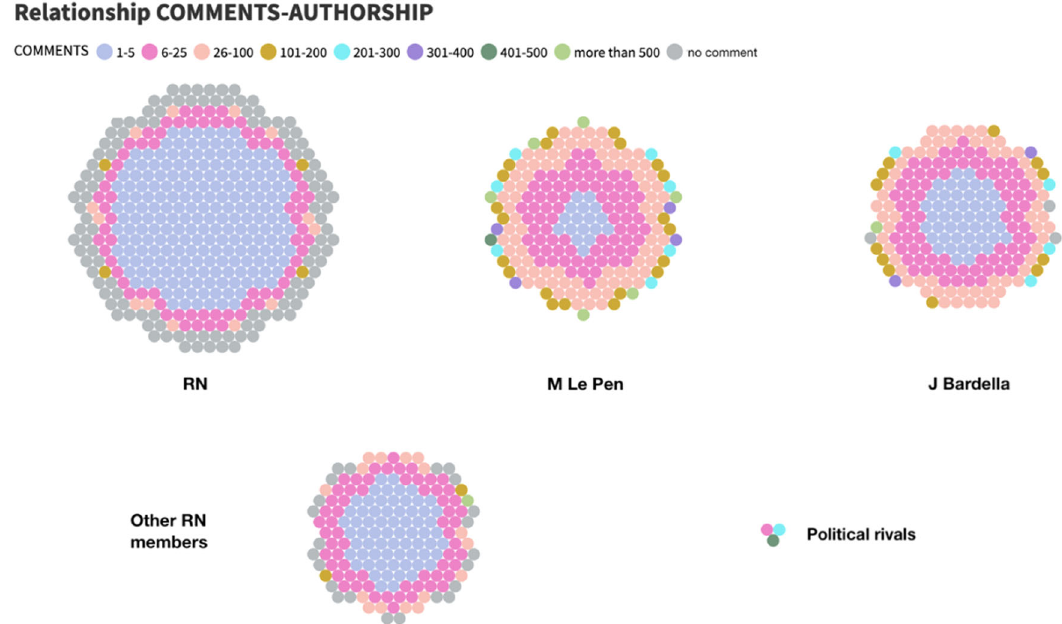
Fig. 5 Relationship between range in comments and authorship of tweets/Own